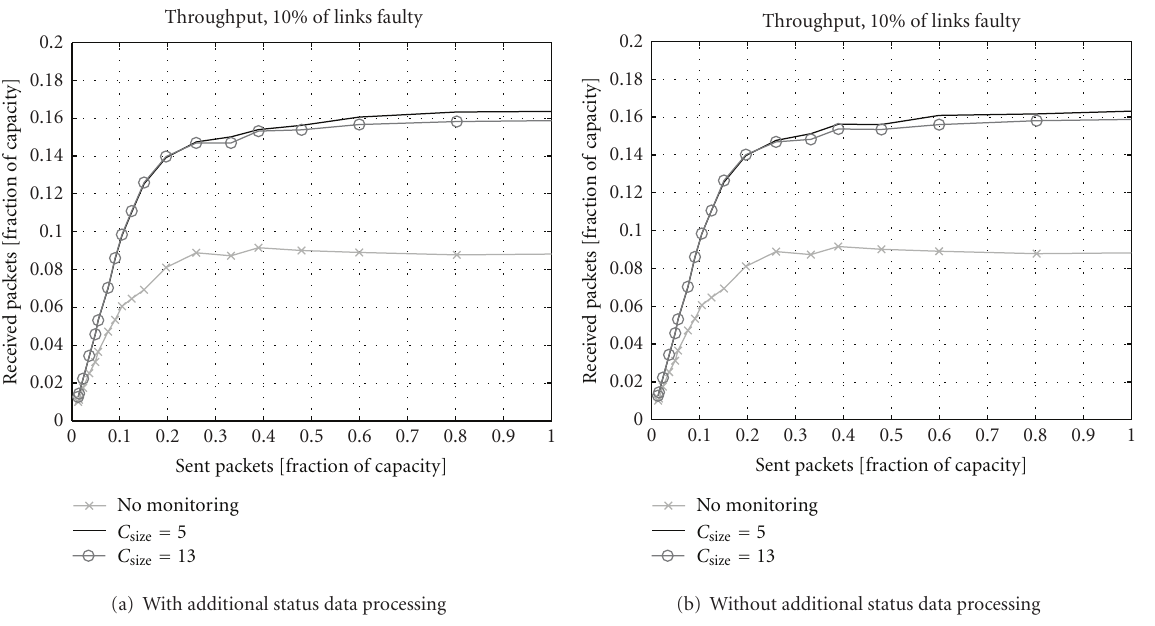
Figure 8: Throughput with di ff erent sized clusters ( C size ). 10% of links are